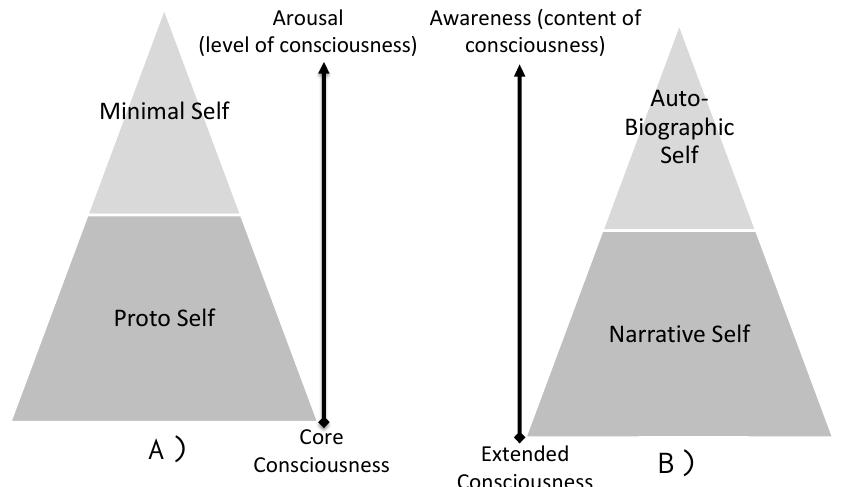
Figure 5. Conceptual analysis of the intervention Protocol: ( A ) Arousal phase and ( B ) Awareness phase. A pyramidal hierarchization is represented for each phase. In ( A ) the Arousal phase, the level of consciousness is plotted. In ( B ) the Awareness phase, the content of consciousness is plotted.